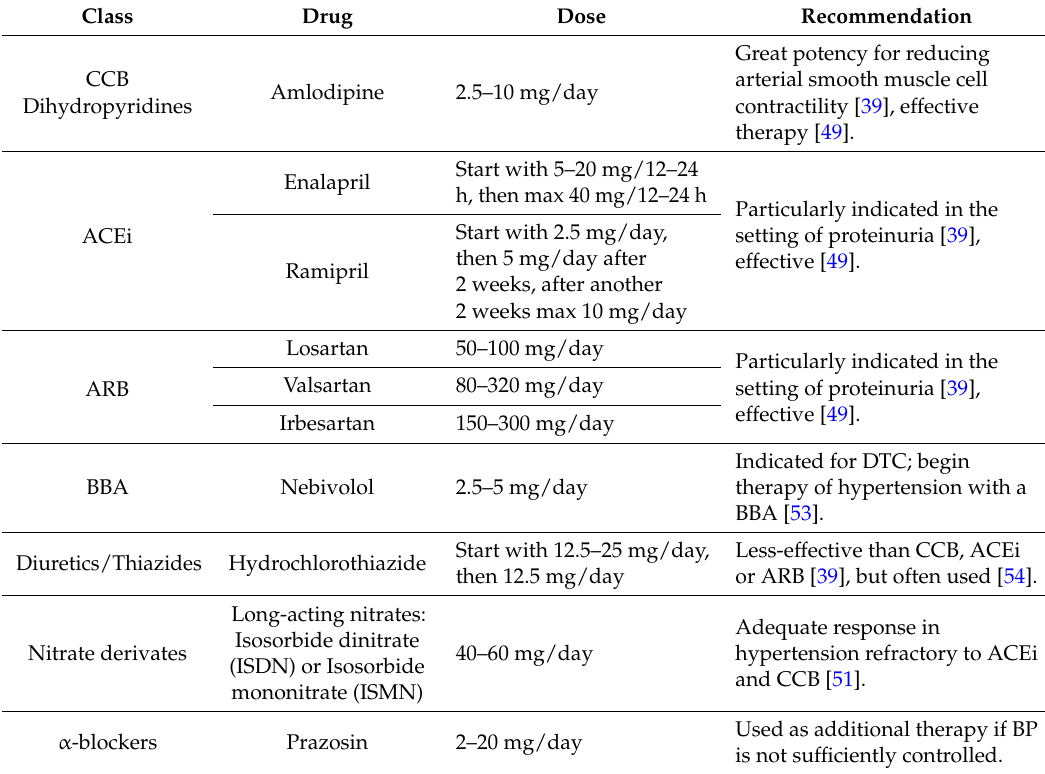
Table 4. Different antihypertensive drugs for the management of TKI-induced